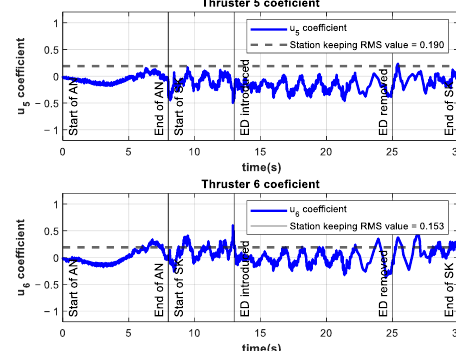
introduced in the interval 13 s ≤ 𝑡 ≤ 25 s . Control signal 𝜏 𝑧 ( left ) and thruster coefficients 𝑢 5 , 𝑢 6